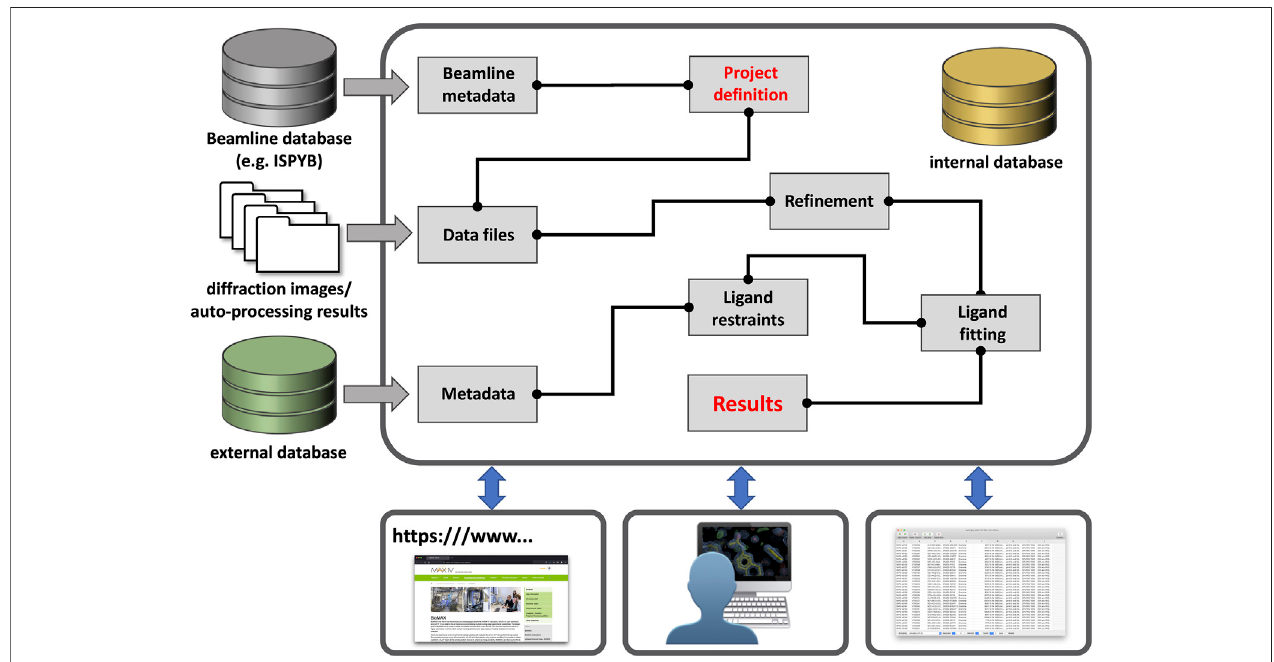
FIGURE 1 | Outline of a generic data processing workbench. Future workbenches will likely be hosted in the cloud [e.g., European Open Science Cloud (EOSC)] andtakeinvarious(meta-)datathroughcustomizableentrypoints.Userscanthende fi nethesample/datarelationshipandconnectpre-de fi nedtasksasneededfortheir work fl ow, such as in KNIME work fl ows. Work fl ows could be saved and shared with any other interested party. All results and work fl ows would be stored in an internal database for each project and local programs or web-services can gain access through a dedicated “ Results ”